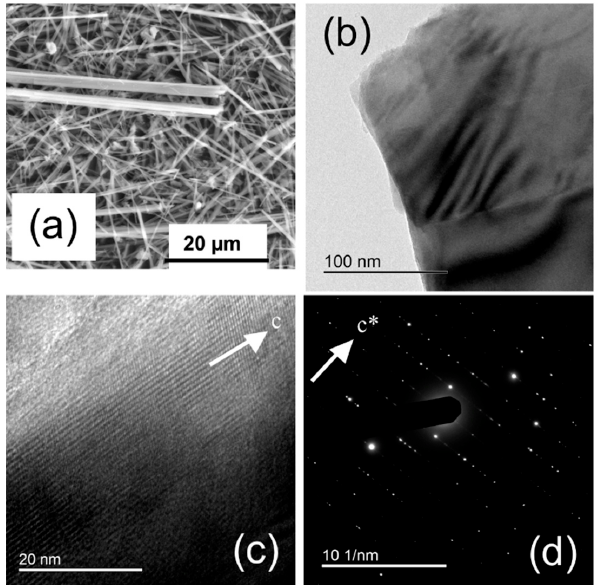
Figure 6. UICC crocidolite NB#4173-111-3 (Table 1). ( a ) Representative FEG-ESEM image of the typical texture of the sample at high magnification. ( b ) HRTEM image with Moir é fringes. ( c ) HRTEM image showing a transition region from a highly crystalline area (streaking along c is clearly visible) to a nearly amorphous boundary. ( d ) Representative SAED pattern parallel to the c*